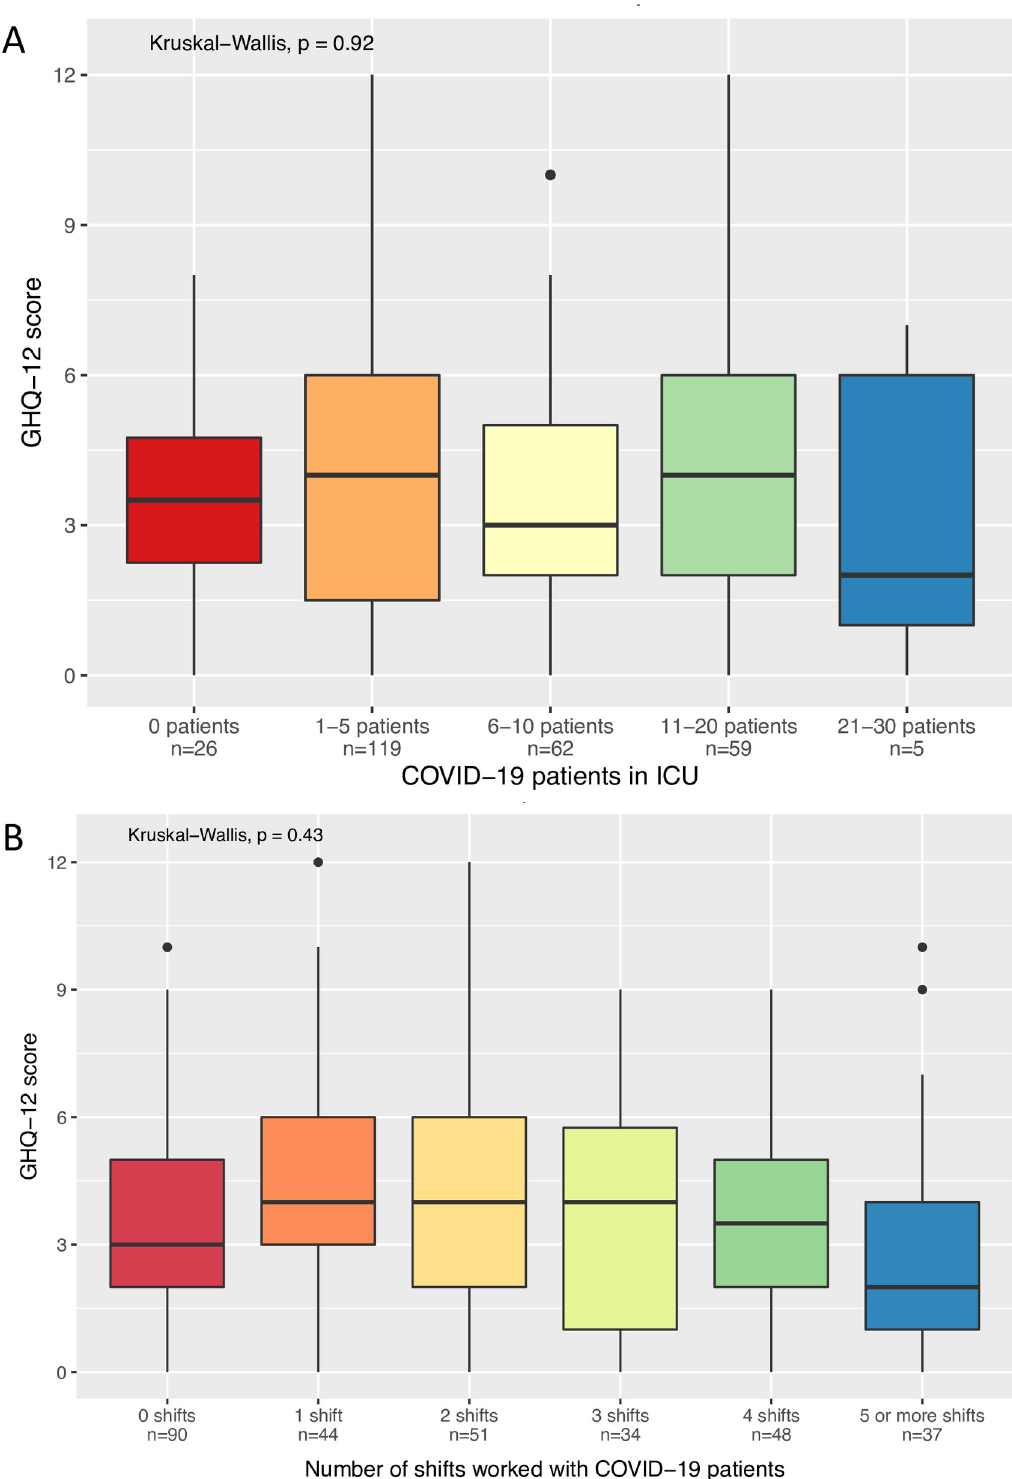
Fig 3. GHQ-12 score relative to markers of COVID-19 exposure. (A) GHQ-12 score relative to number of COVID-19 patients in the participant’s ICU in the previous week. (B) GHQ-12 scores relative to number of shifts worked with COVID-19 patients in the previous